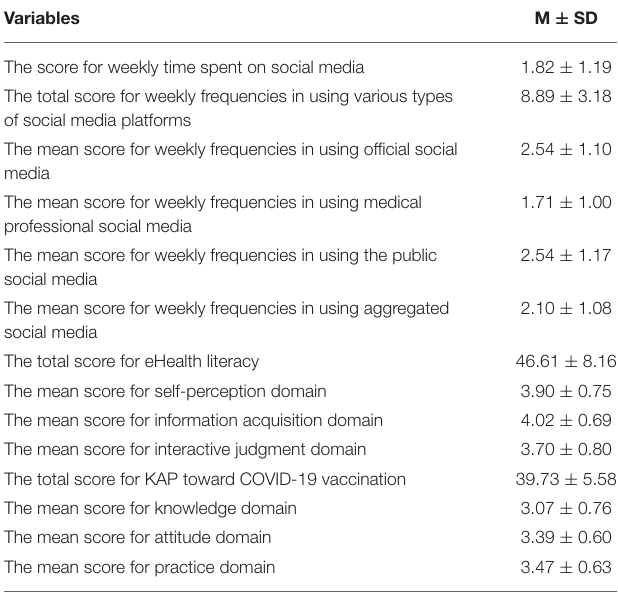
TABLE 2 | Social media use, eHealth literacy, and KAP toward COVID-19 vaccination. Variables